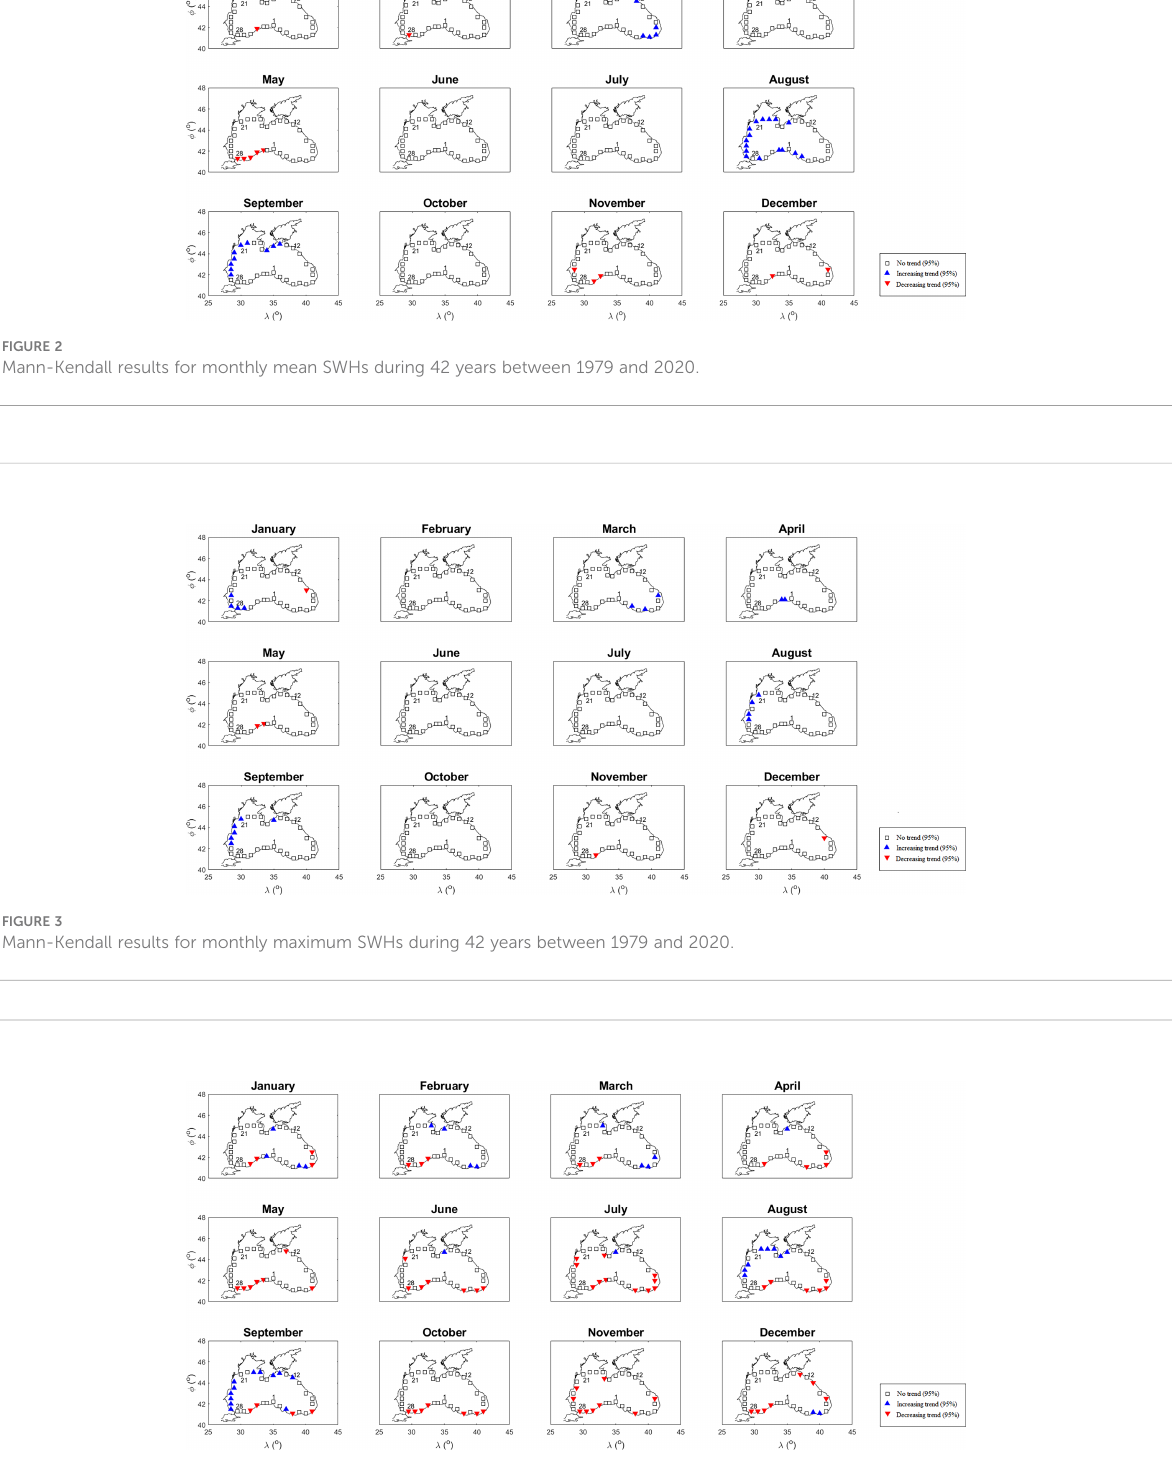
FIGURE 4 Mann-Kendall results for monthly mean WSs during 42 years between 1979 and